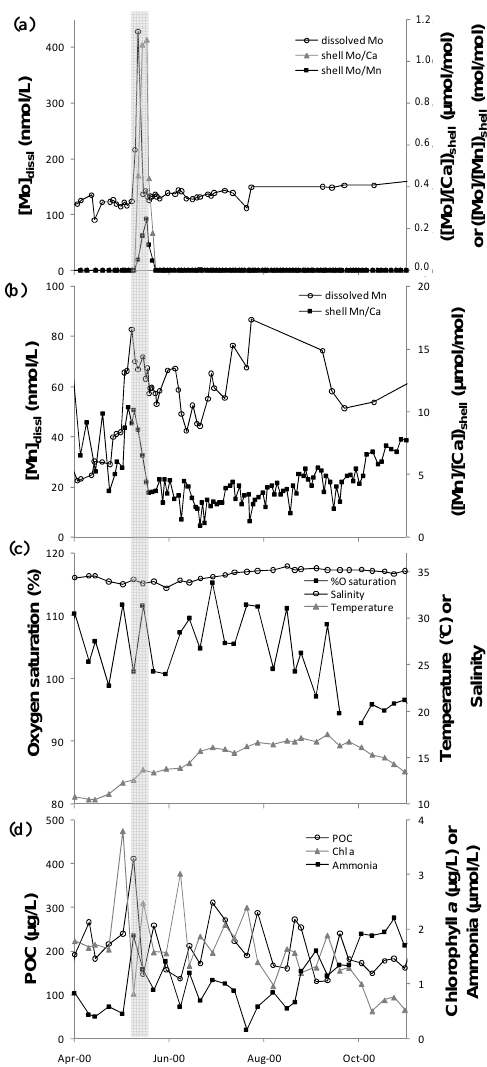
Fig. 5. (a) Mean ([Mo]/[Ca]) shell and ([Mo]/[Mn]) shell profiles ( n = 3) obtained in 2000 in the Bay of Brest and Mo concentra- tions (nmol/L) in dissolved seawater (sampled 1m above the SWI) compared with (b) mean ([Mn]/[Ca]) shell profiles and dissolved Mn concentrations (nmol/L); (c) seawater temperature ( ◦ C), salinity and oxygen saturation (%); and (d) particulate organic carbon (POC), chlorophyll a (µg/L) and ammonia (µmol/L)